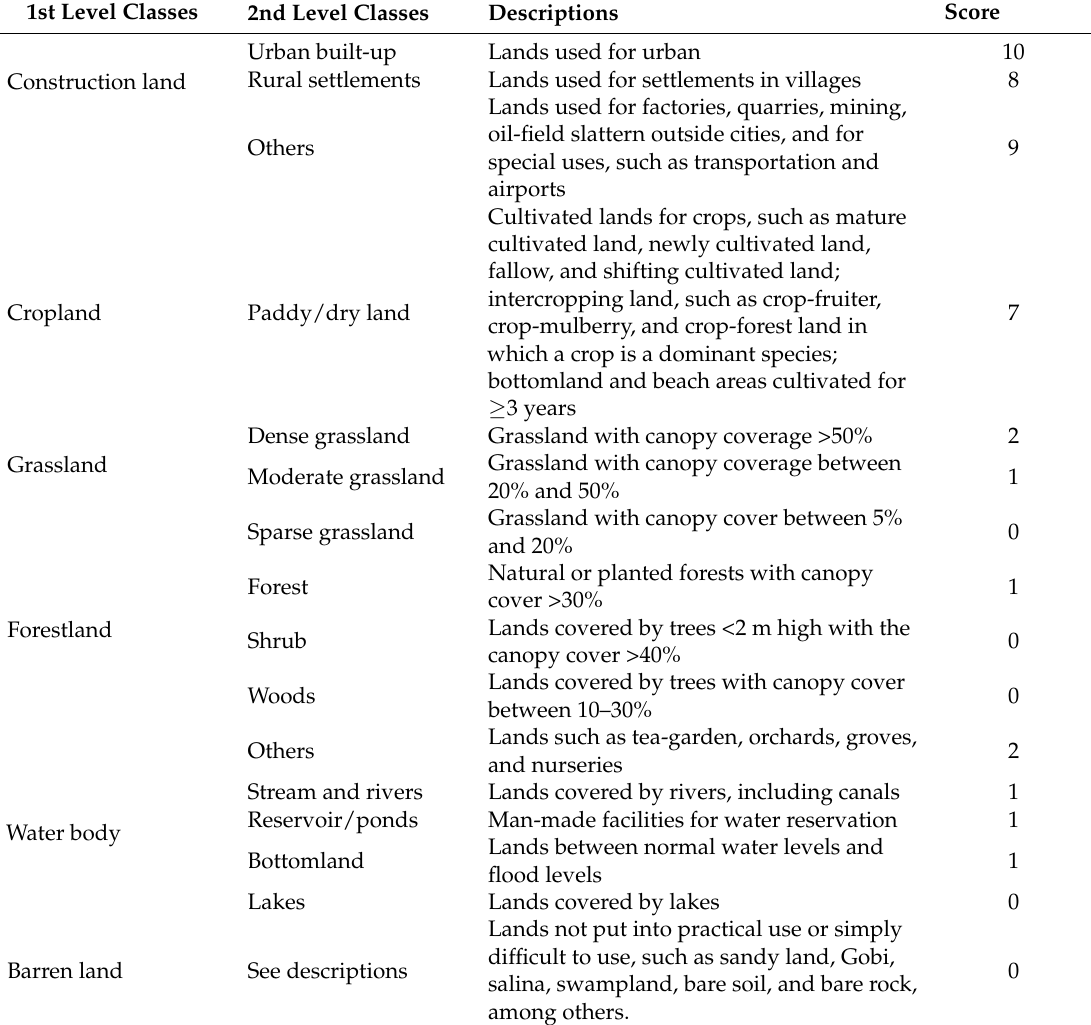
Table 1. Land use types [57,58] and the human influence scores assigned to each type based on the relative disturbance degree calculated in relevant studies [31,59–61]. This table was taken from reference [56] and revised